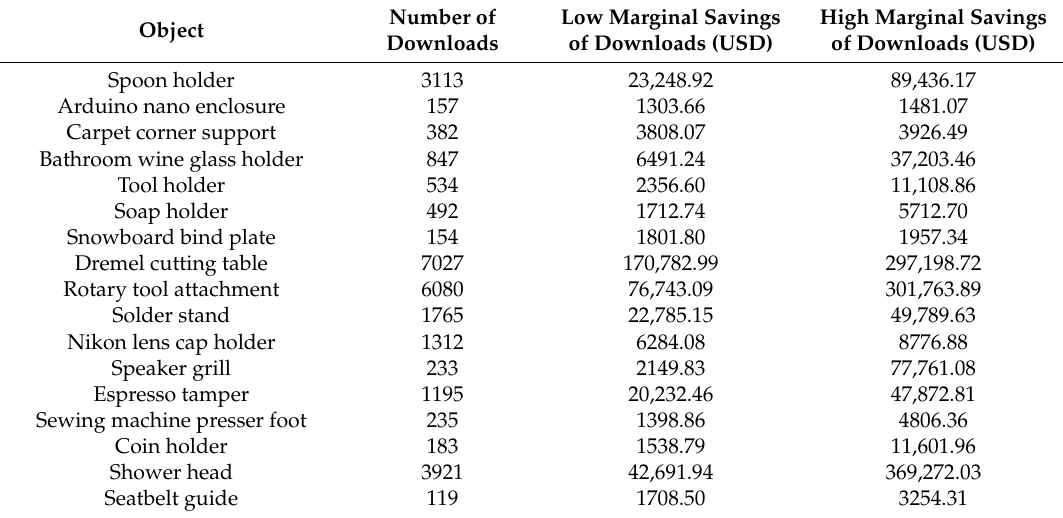
Table 4. The downloaded substitution value for the 26 free design example